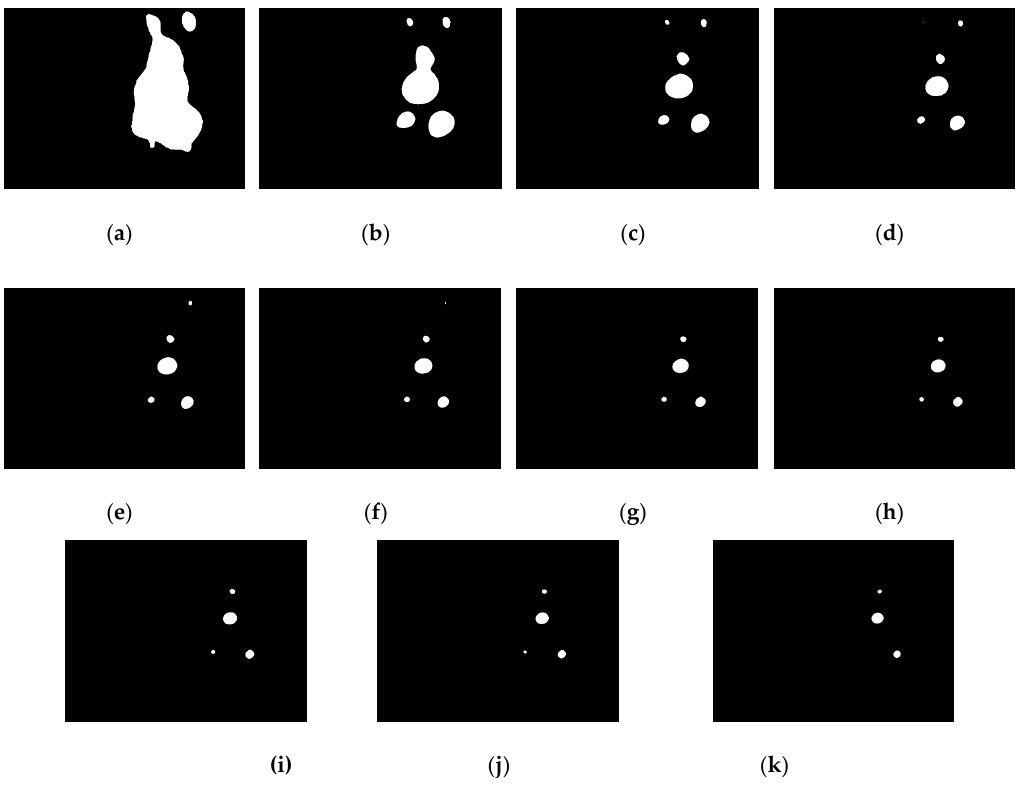
Figure 5. The binary images through ( a ) the original OTSU method and ( b – k ) the weighted OTSU method with weight coefficient K from 0.9 to 0 at a step size of 0.1: ( a ) K = 1, T = 48; ( b ) K = 0.9, T = 71; ( c ) K = 0.8, T = 103; ( d ) K = 0.7, T = 128; ( e ) K = 0.6, T = 150; ( f ) K = 0.5, T = 170; ( g ) K = 0.4, T = 188; ( h ) K = 0.3, T = 205; ( i ) K = 0.2, T = 219; ( j ) K = 0.1, T = 233; ( k ) K = 0, T = 245.